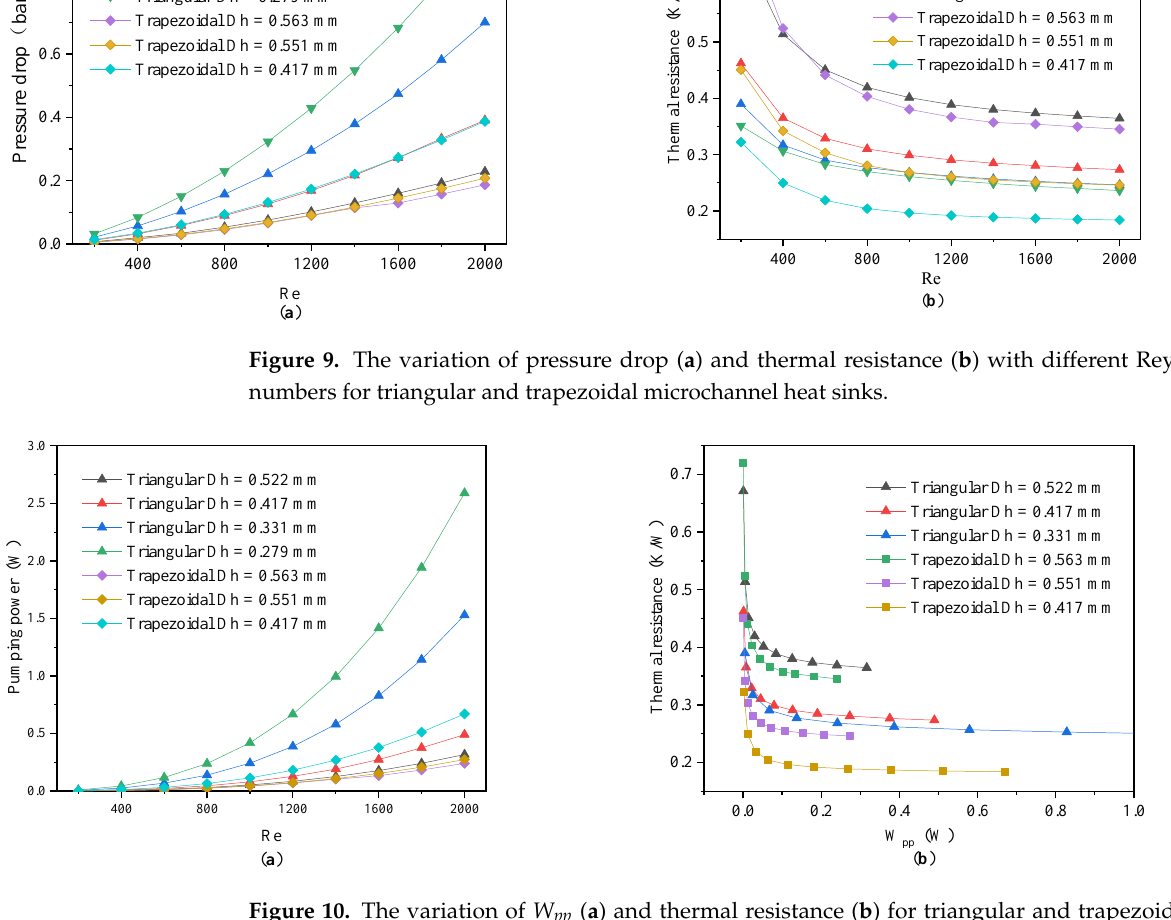
Figure 9. The variation of pressure drop ( a ) and thermal resistance ( b ) with different Reynolds numbers for triangular and trapezoidal microchannel heat sinks.